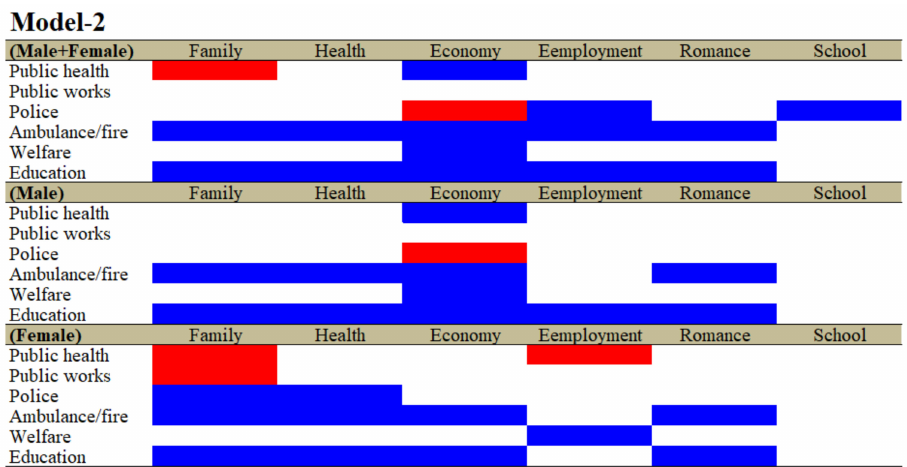
Figure 2. Relationship between financial expenditure per capita of six major divisions of prefec- tures/municipalities and suicide mortalities caused by six major motives for both genders (males + females), males and females between 2009 and 2018 using fixed- or random-effect analyses of hierarchal linear regression with robust standard error. Blue and red columns denote significant factors for decreasing and increasing suicide mortalities, respectively. The detailed statistical values are represented in Supplementary Tables